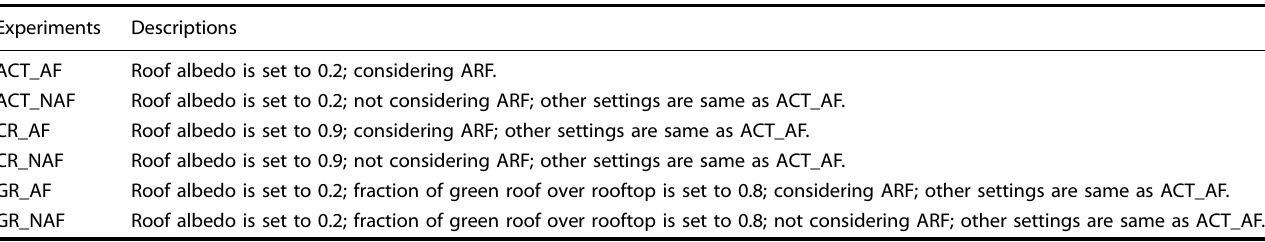
Table 1. Descriptions of model